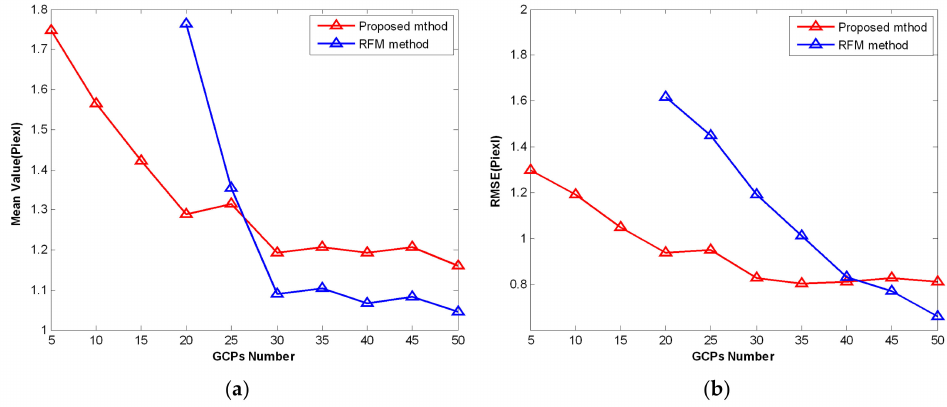
Figure 7. The variation trends of ( a ) mean value and ( b ) root mean square error (RMSE) of the number of GCPs across the two methods.